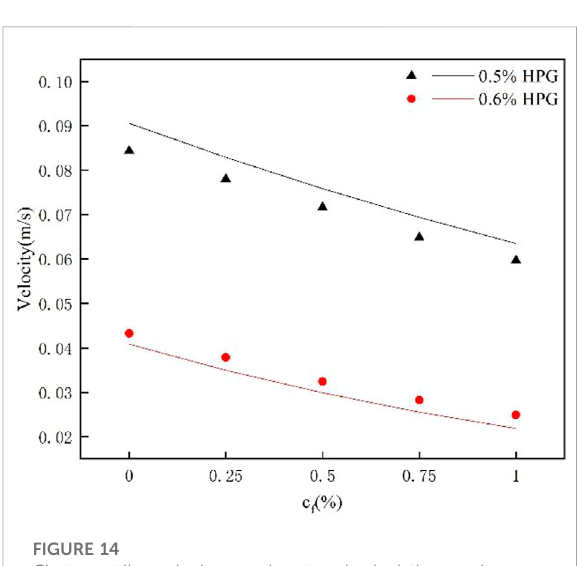
FIGURE 14 Cluster settling velocity experiment and calculation